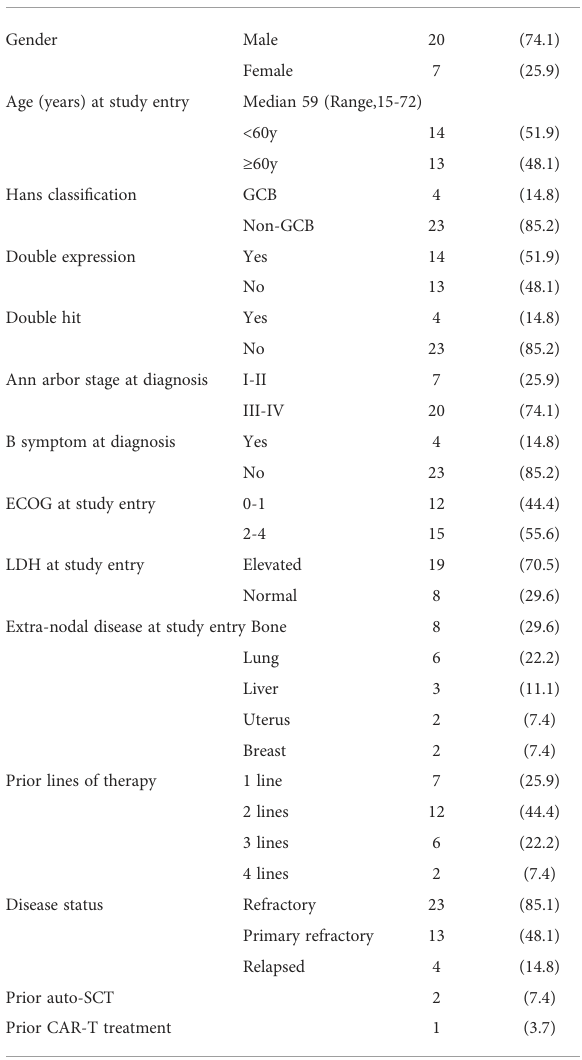
TABLE 1 Demographics and baseline